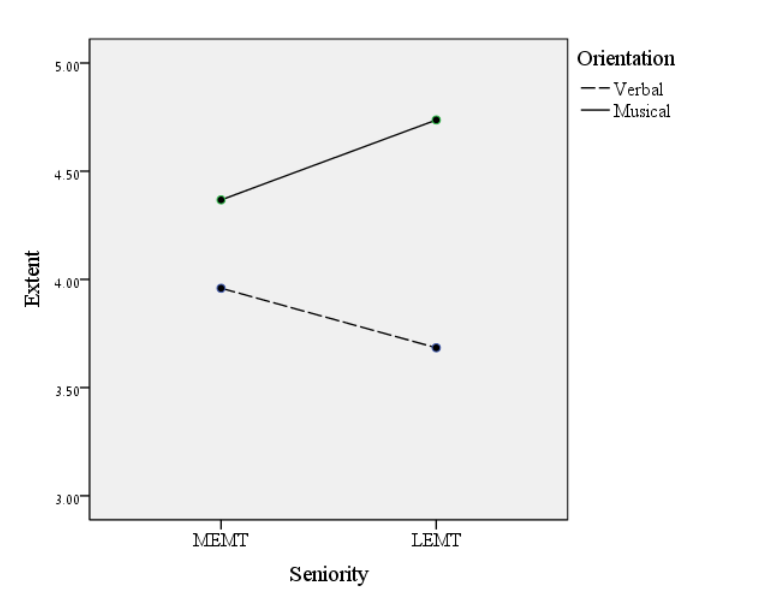
FFigigururee 33 Music therapy orientation (musical vs. verbal), comparing MEMTs and LEMTs